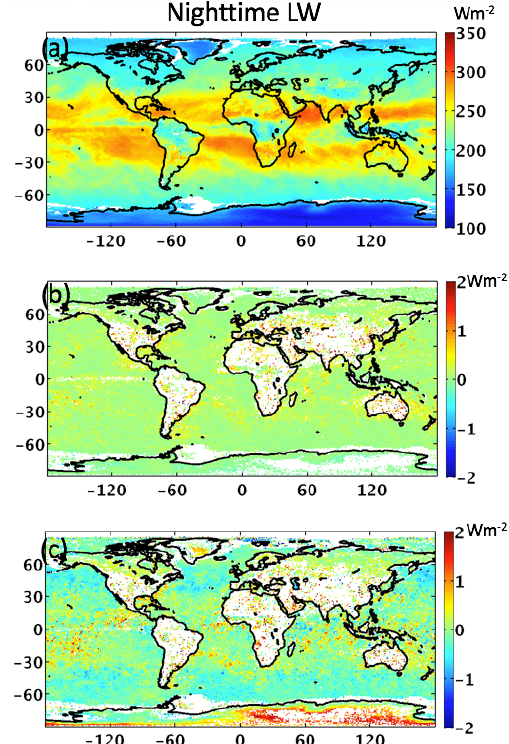
Figure 9. The gridded monthly mean TOA nighttime LW fluxes from the simulated Aqua footprints ( F s a , a ), the flux differences caused by footprint size difference between simulated NPP and sim- ulated Aqua ( F s n − F s a , b ), and the flux differences caused by both footprint size and cloud property differences ( F (cid:48) ns − F s a , c ) using April 2013 data. Regions shown in white have large sample number differences between simulated Aqua and simulated